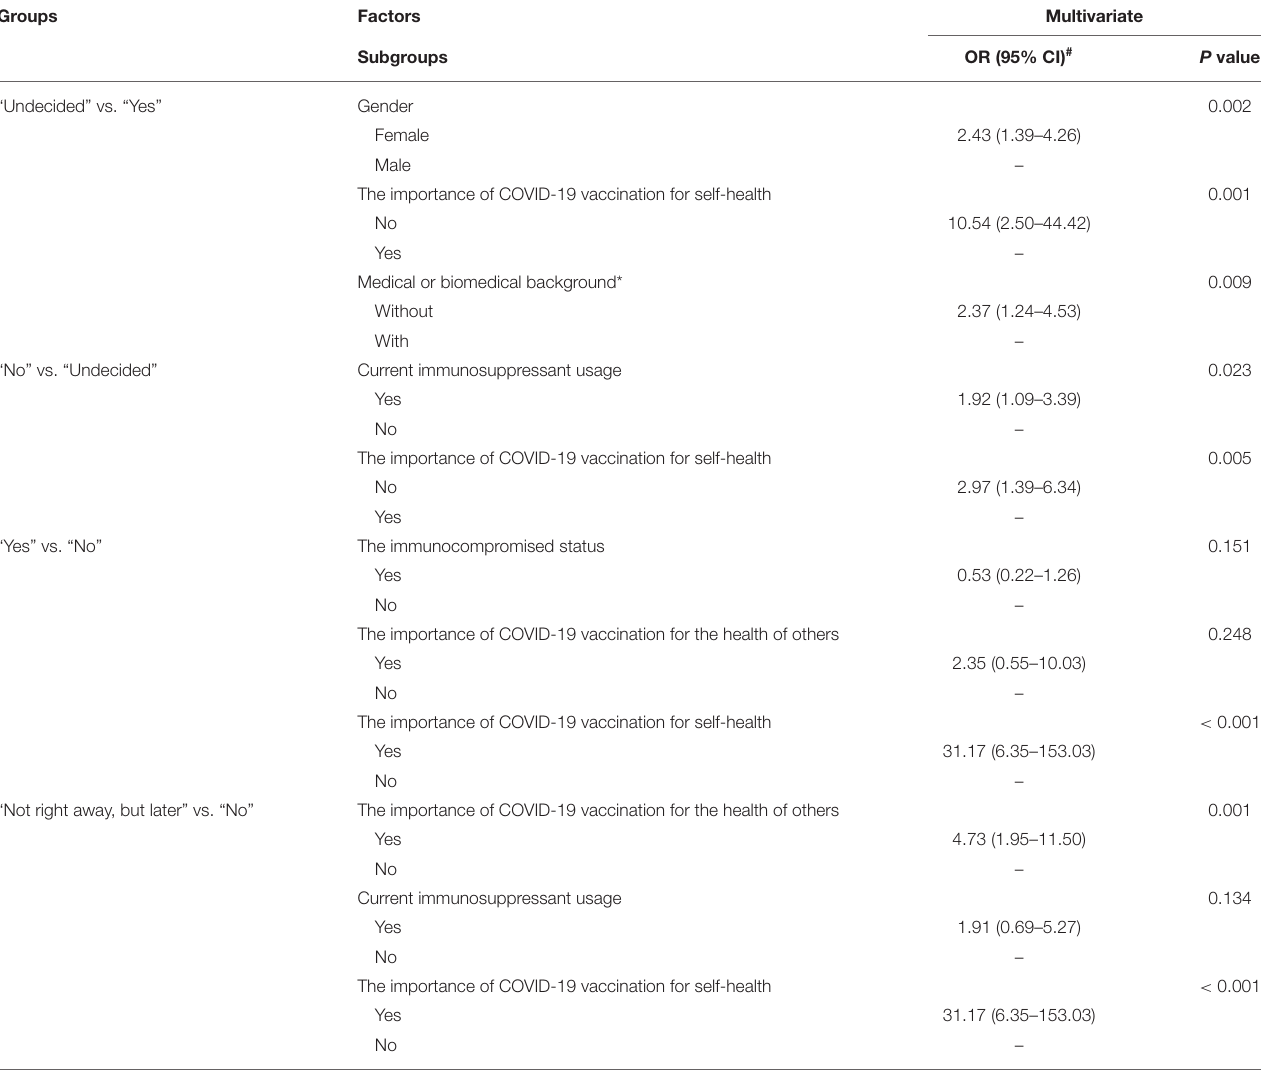
TABLE 3 | The independent factors impacting the attitude of patients toward SARS-CoV-2 vaccination, identified by Binary Logistic Analysis. Groups Factors Multivariate Subgroups OR (95% CI) # P value “Undecided” vs.